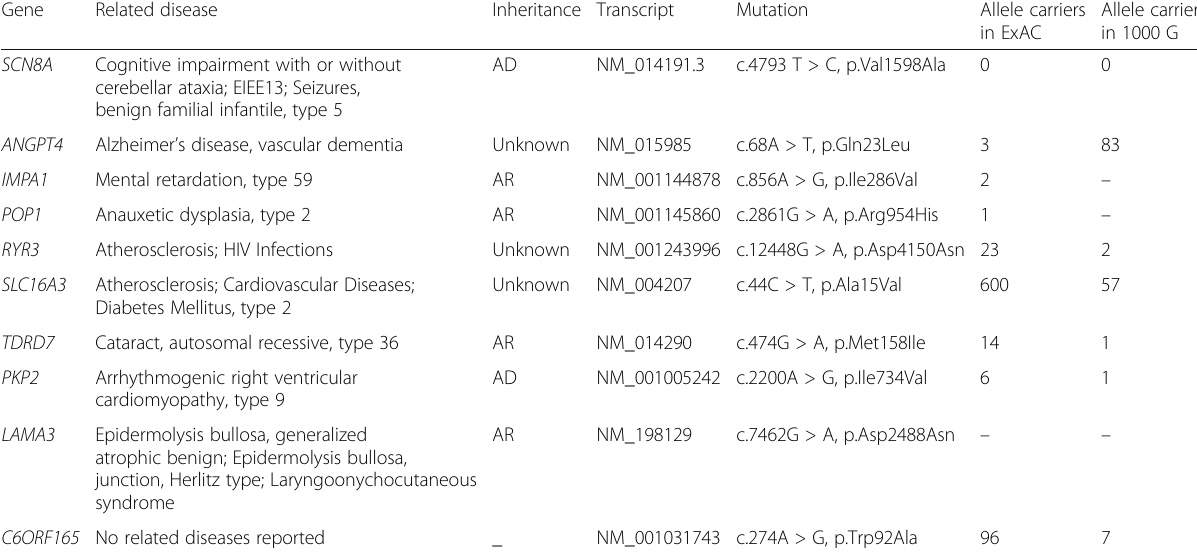
Table 2 10 candidate genes identified in the family case and their related disease